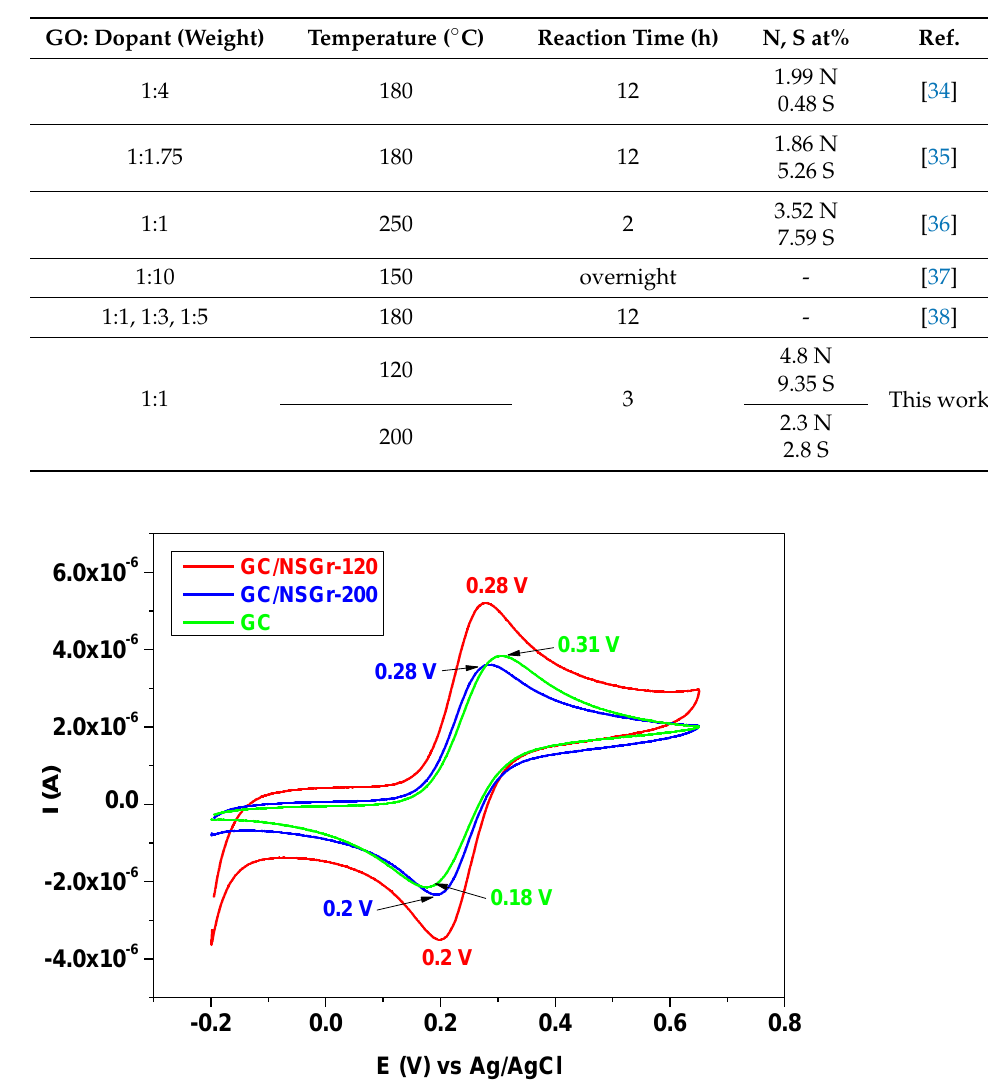
Figure 8. Cyclic voltammograms recorded with bare GC (green), GC/NSGr-200 (blue), and GC/NSGr-120 (red) electrodes. Electrolyte: 1 mM K 4 [Fe(CN) 6 ] + 0.2 M KCl; scan rate: 10 mVs −1 . Table 5. The electrochemical parameters of GC, GC/NSGr-200, and GC/NSGr-120 electrodes determined from